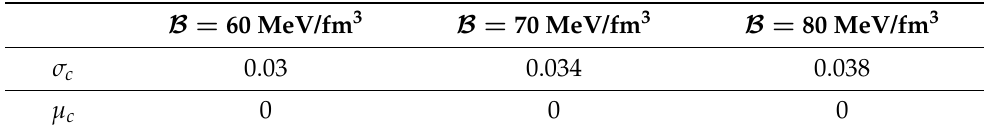
Table 2. Initial conditions corresponding to solution II for different values of the bag constant corresponding to Υ = 0.2, 0.9.